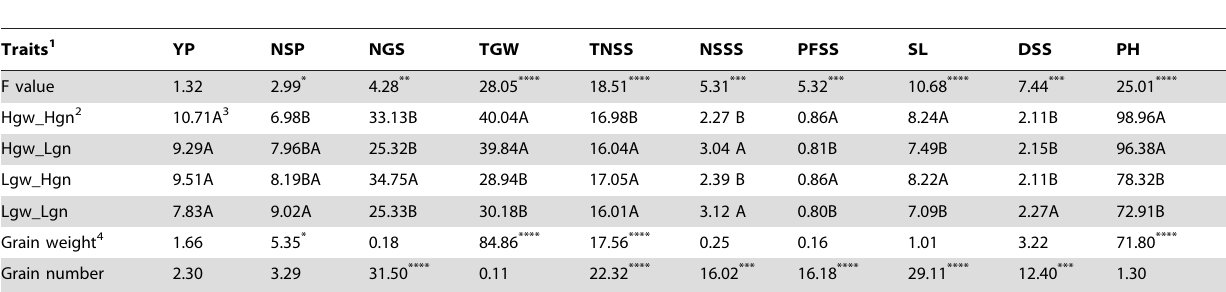
Table 9. Performances for traits of four 1000 grain weight (gw) - grain number per spike (gn) groups of wheat DH lines from analyses across different